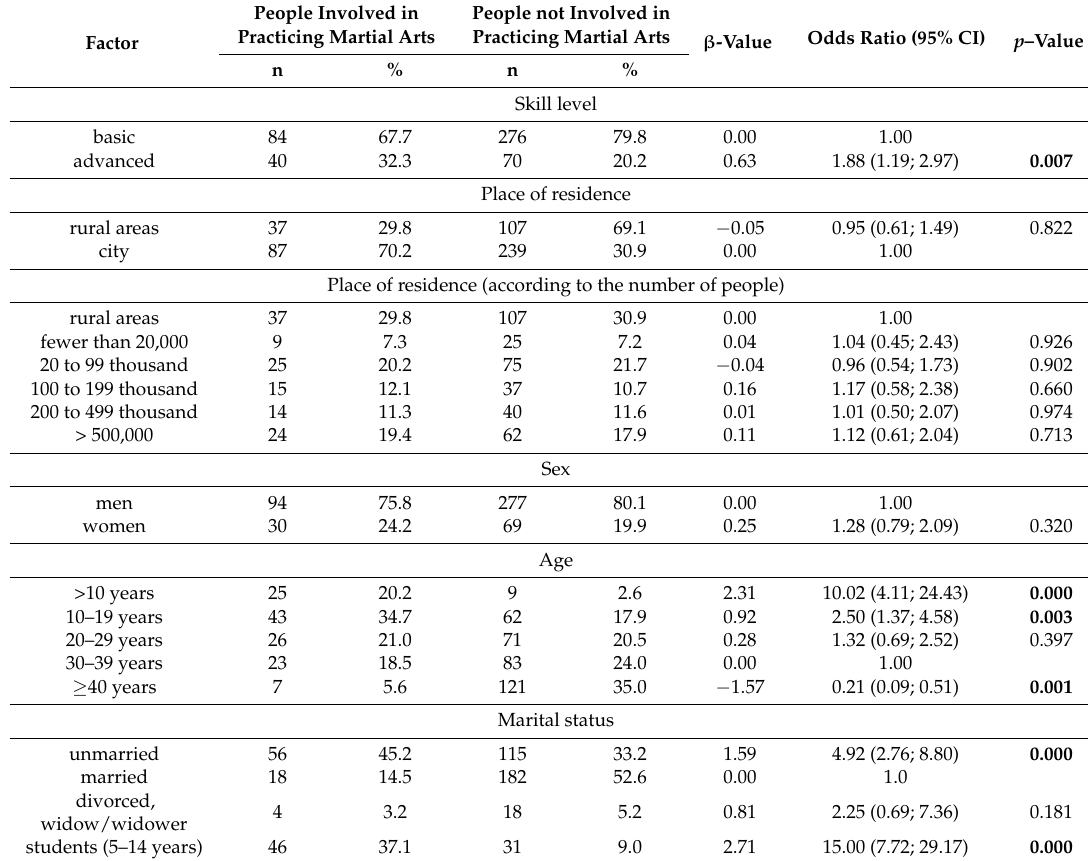
Table 1. Factors determining practicing of martial arts in the Polish population (n = 470), odds ratios (OR) at 95% confidence interval (95%